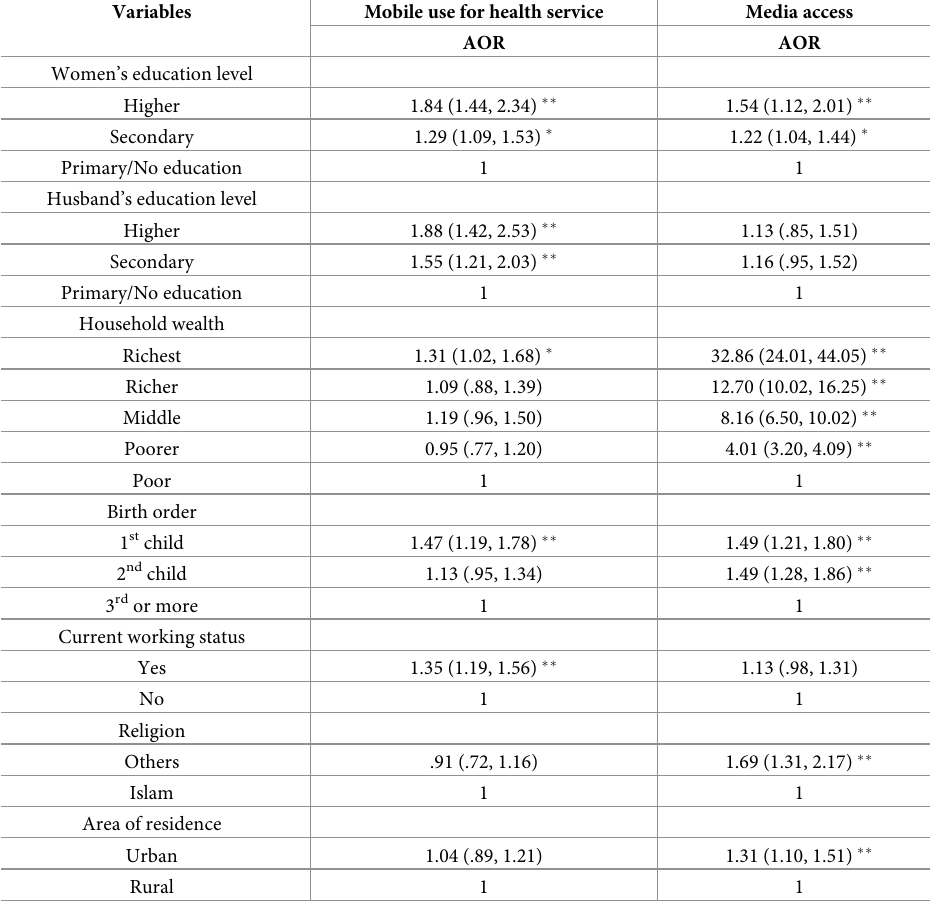
Table 4. Factors affecting media access and mobile